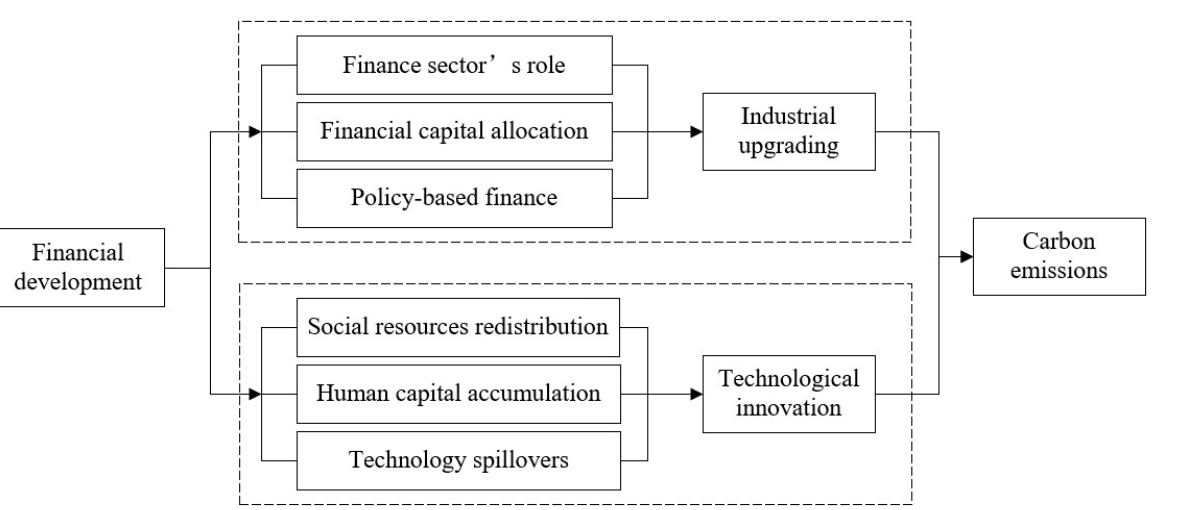
Figure 1. Impact mechanism analysis.